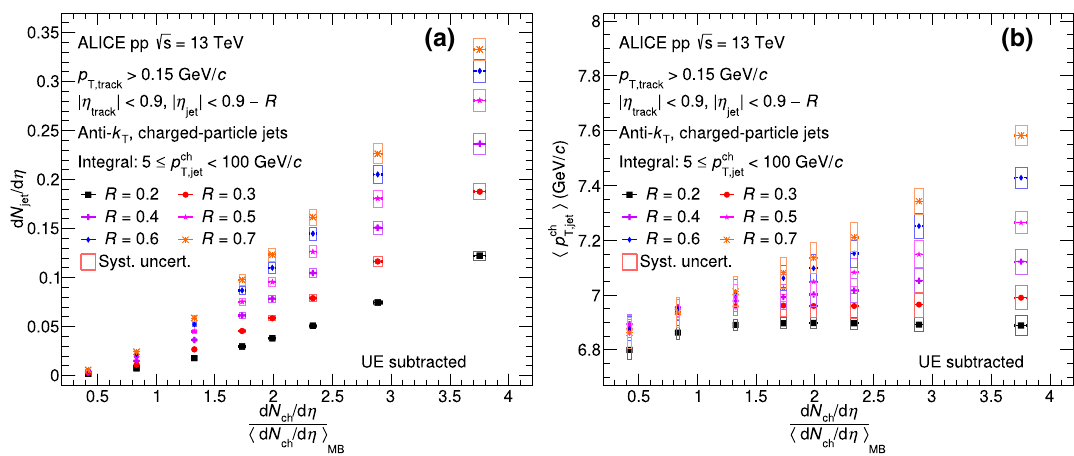
< charged-particle multiplicitiesprovided in Ref. [66]. Statisticaland sys- T , jet tematic uncertainties are shown as vertical error bars and boxes around the data points,